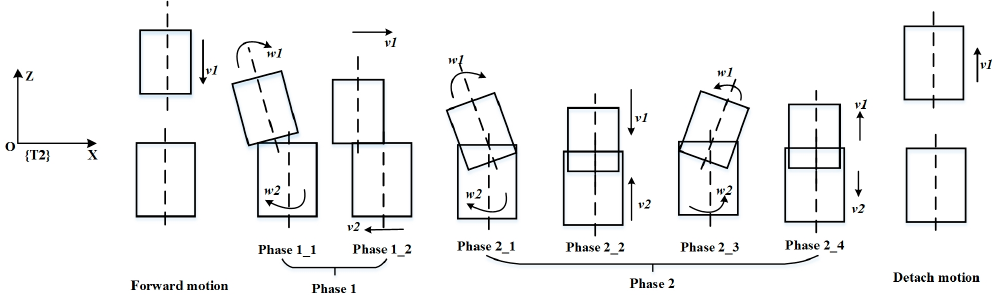
Figure 5. Two-phase assembly scheme ( Phase 1 : outside adjustment; Phase 2 : inside adjustment; Phase 1_1 and Phase 1_2 are outside orientation adjustment and outside position adjustment, respectively; Phase 2_1, Phase 2_2, Phase 2_3 and Phase 2_4 are peg insertion orientation adjustment, peg insertion, peg removal orientation adjustment, and peg removal, respectively).